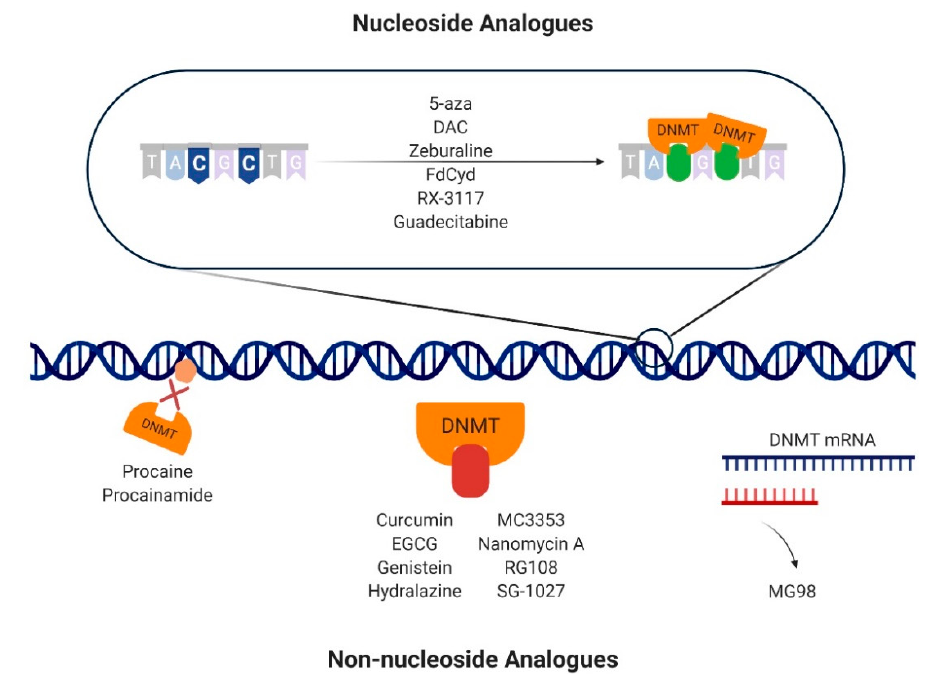
Figure 3. Mechanisms of action of DNA methyltransferase (DNMT) inhibitors. The nucleoside analogues 5-azacitydine (5-aza), decitabine (DAC), zebularine, 5 ′ -fluoro-2 ′ -deoxycytidine (FdCyd), RX-3117, and guadecitabine are integrated into DNA instead of cytosine. When DNMTs bind, a covalent bond is formed between the DNMT and the cytosine analogue. The non-nucleoside analogues have different mechanism of action to achieve inhibition of DNA methylation. Specifically, procaine and procainamide bind directly to the DNA, impeding DNMT binding. Curcumin, epigallocatechin-3-gallate (EGCG), genistein, hydralazine, MC3353, nanomycin A, RG108, and SG-1027 bind directly to the catalytic pockets of DNMTs, hampering their action. MG98 is an oligodeoxynucleotide that binds to the DNMT1 messenger RNA (mRNA) by base pair complementarity, impeding its translation.